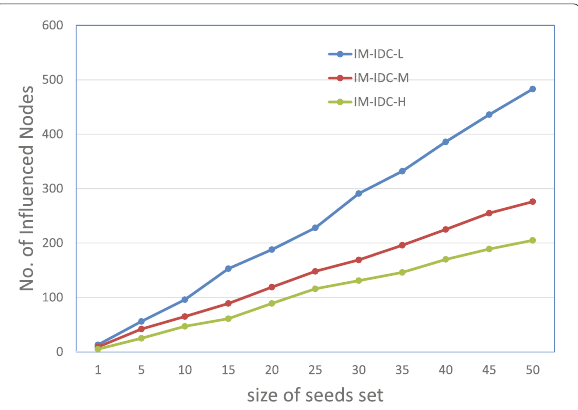
Fig. 4 The No. of influence set size on LiveJournal data while increasing the size of seed nodes, where IM-IDC-L, IM-IDC-M, and IM-IDC-H are A PPRO IM-IDC with low , medium , and high context